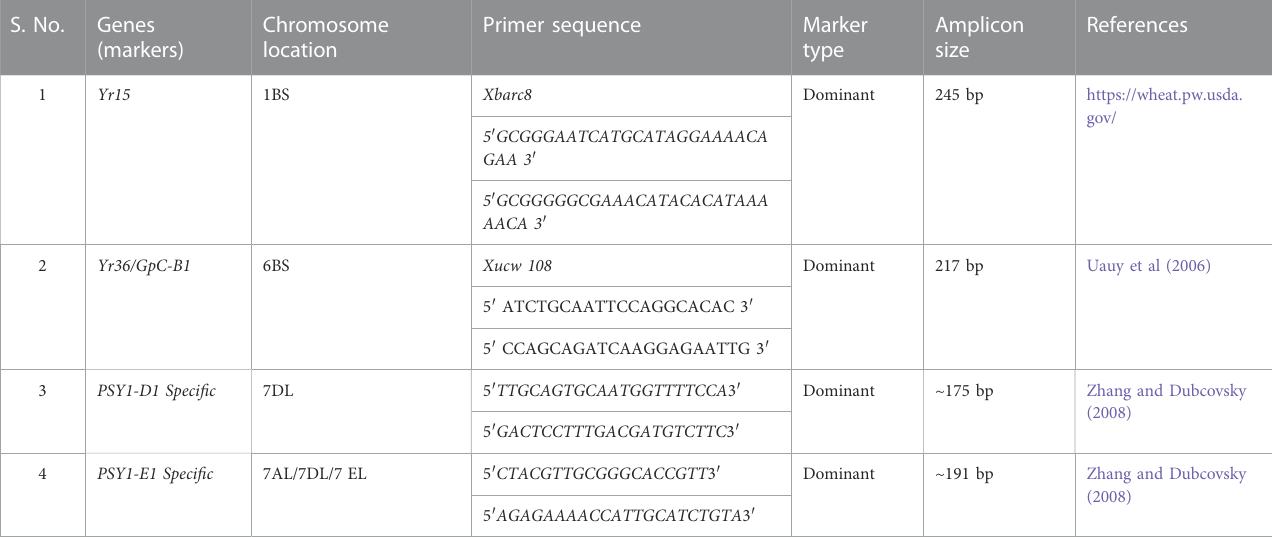
TABLE 2 Markers, their sequences used for Marker Assisted Selection. S.